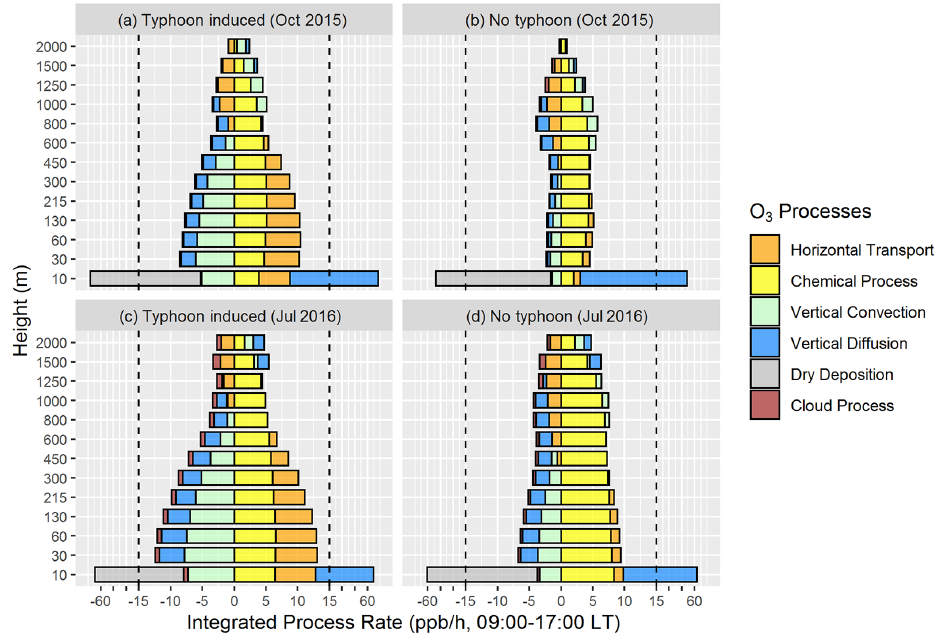
Figure 9. The daytime mean (09:00–17:00LT) hourly contributions of O 3 processes within the PRD in vertical layers 1–13 on representative O 3 pollution days. (a) The typhoon-induced days in October 2015 (14–16 and 21 October 2015). (b) The no-typhoon days in October 2015 (28 October and 3–5 November 2015). (c) The typhoon-induced days in July 2016 (7–8 and 30–31 July 2016). (d) The no-typhoon days in July 2016 (22–26 and 29 July